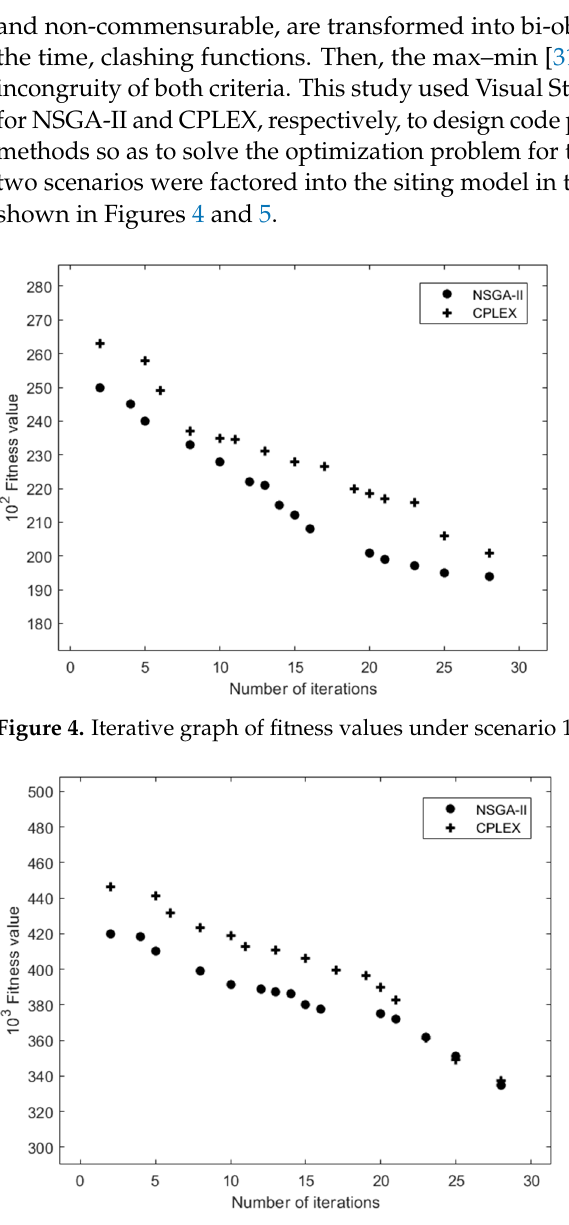
Figure 5. Iterative graph of the fitness values in Scenario 2.